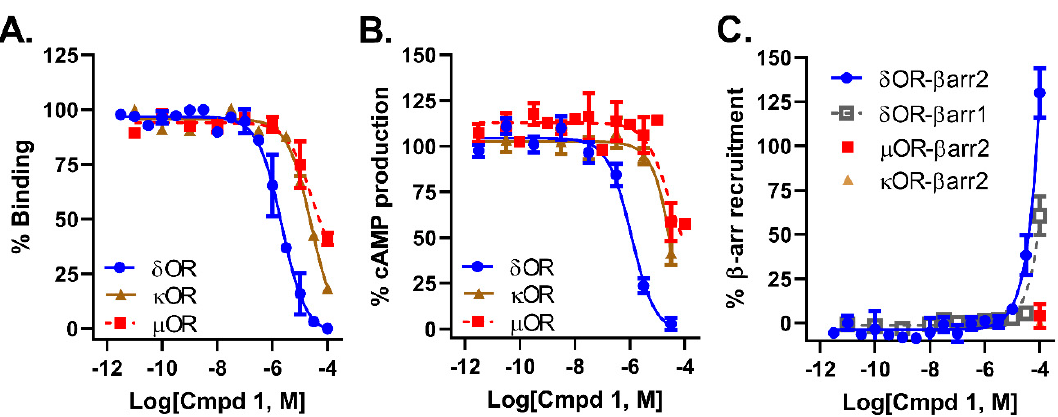
Figure 3. Pharmacological characterization of compound 1 . ( A ). Binding affinity for compound 1 . At δ OR, µ OR and κ OR. ( B ). Inhibition of forskolin induced cAMP by compound 1 in cells expressing δ OR, µ OR and κ OR. ( C ). β -arrestin recruitment for compound 1 following stimulation of δ OR, µ OR and κ OR. Table 1. Pharmacological characterization of compound 1 . All assays were run in three or more independent trials. ND = not detected.